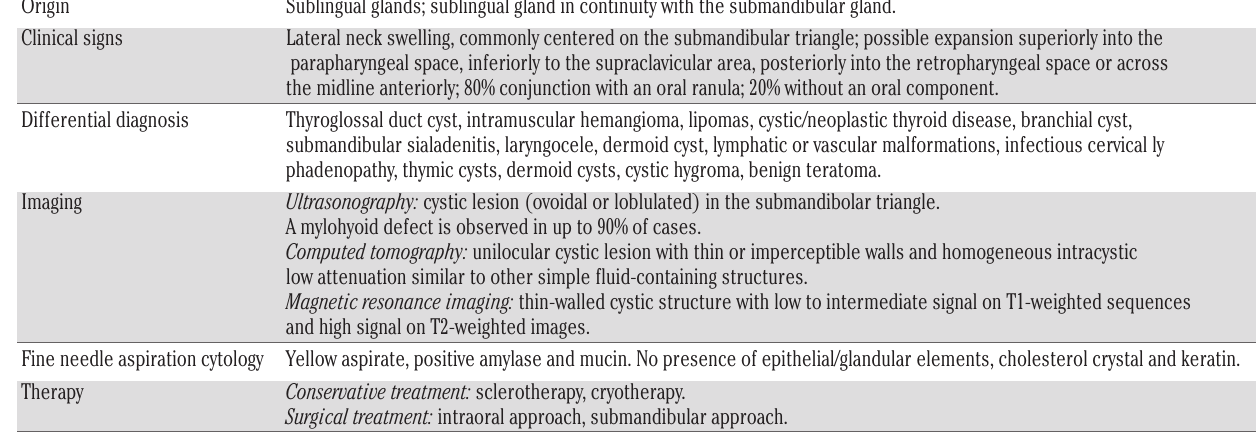
low attenuation similar to other simple fluid-containing structures. Magnetic resonance imaging: thin-walled cystic structure with low to intermediate signal on T1-weighted sequences and high signal on T2-weighted